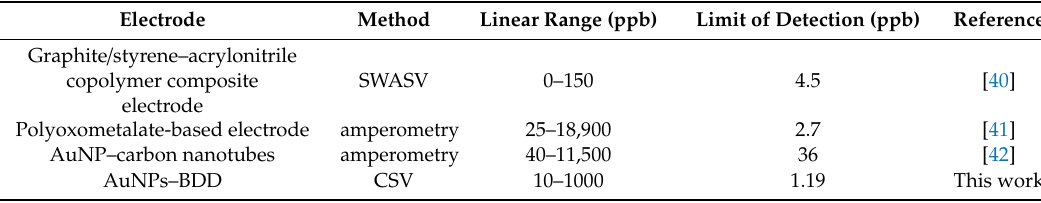
Table 3. Comparison with other methods for the detection of Cr